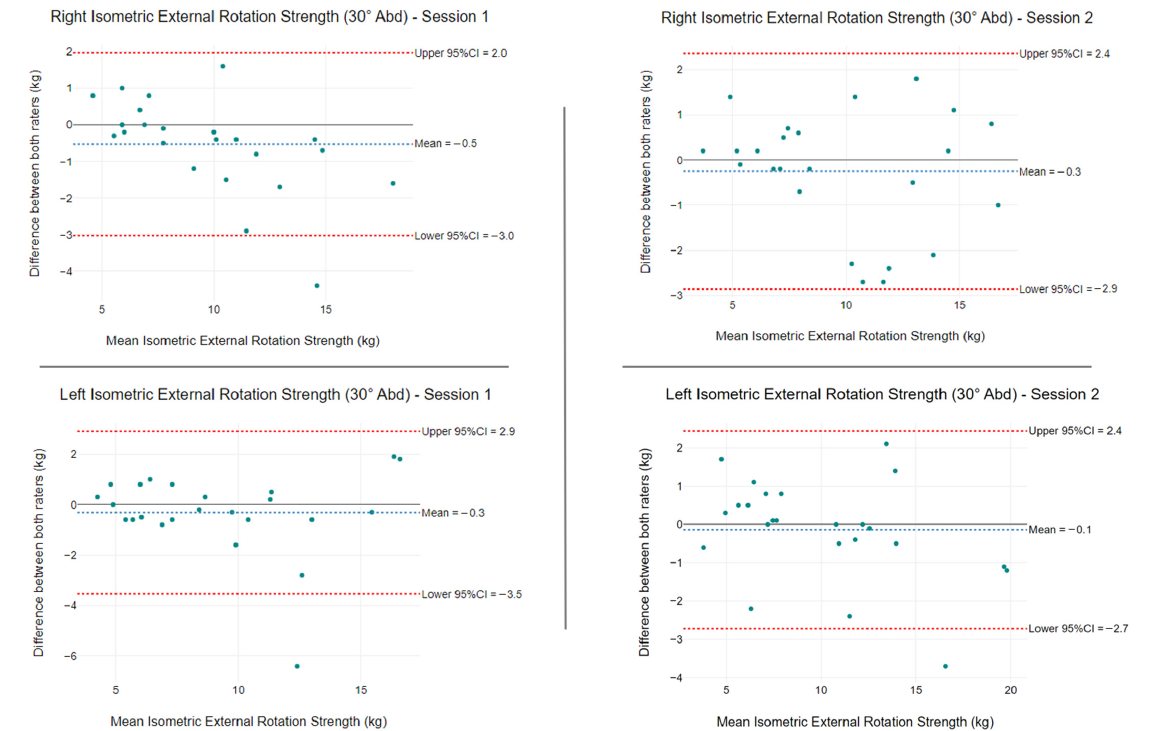
Figure 6. HBB differences between raters using tape measure for left and right sides. The blue seg- mented line is the mean difference between raters, and the segmented red lines show the 95% LoA.